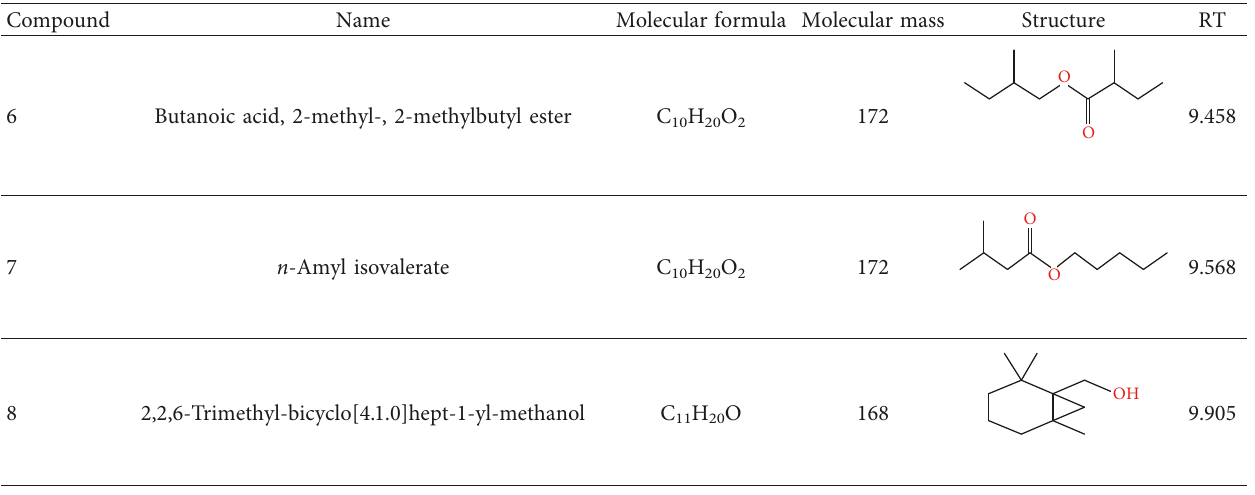
Table 3: Molecular formula, molecular mass, structure, and RTof compounds 6–10 of whole plant n -hexane fraction of Achillea wilhelmsii